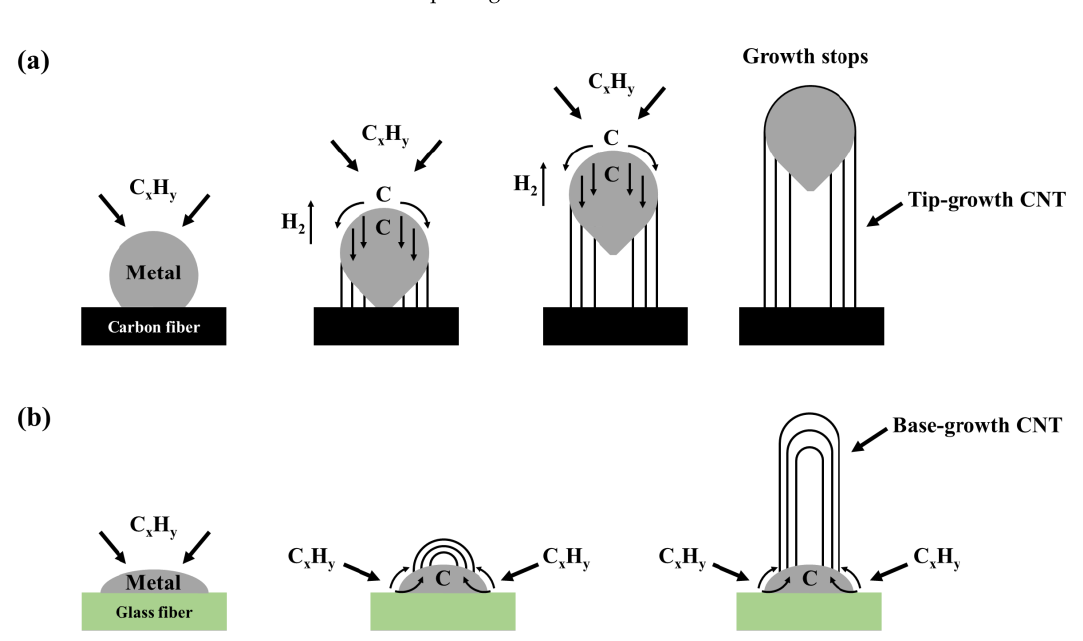
Figure 4. XRD patterns of the ( a ) carbon fibers with grown CNTs and ( b ) glass fibers with grown CNTs as a function of plating time.